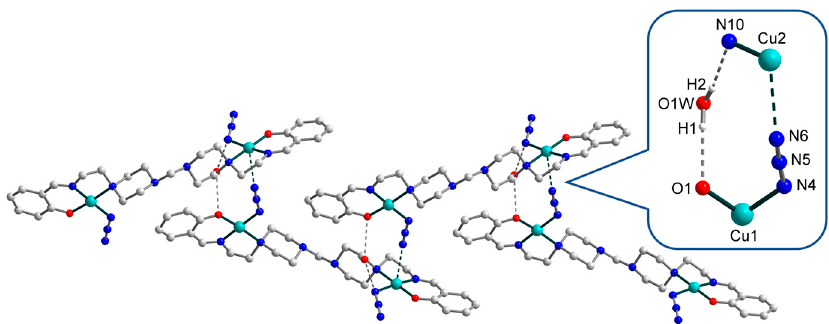
Figure 5. Molecular structure of 2 (building unit) showing the atom numbering. H atoms and uncoordinated water molecule are omitted for clarity. Colour scheme: Cu, cyan; O, red; N, blue; C, grey.